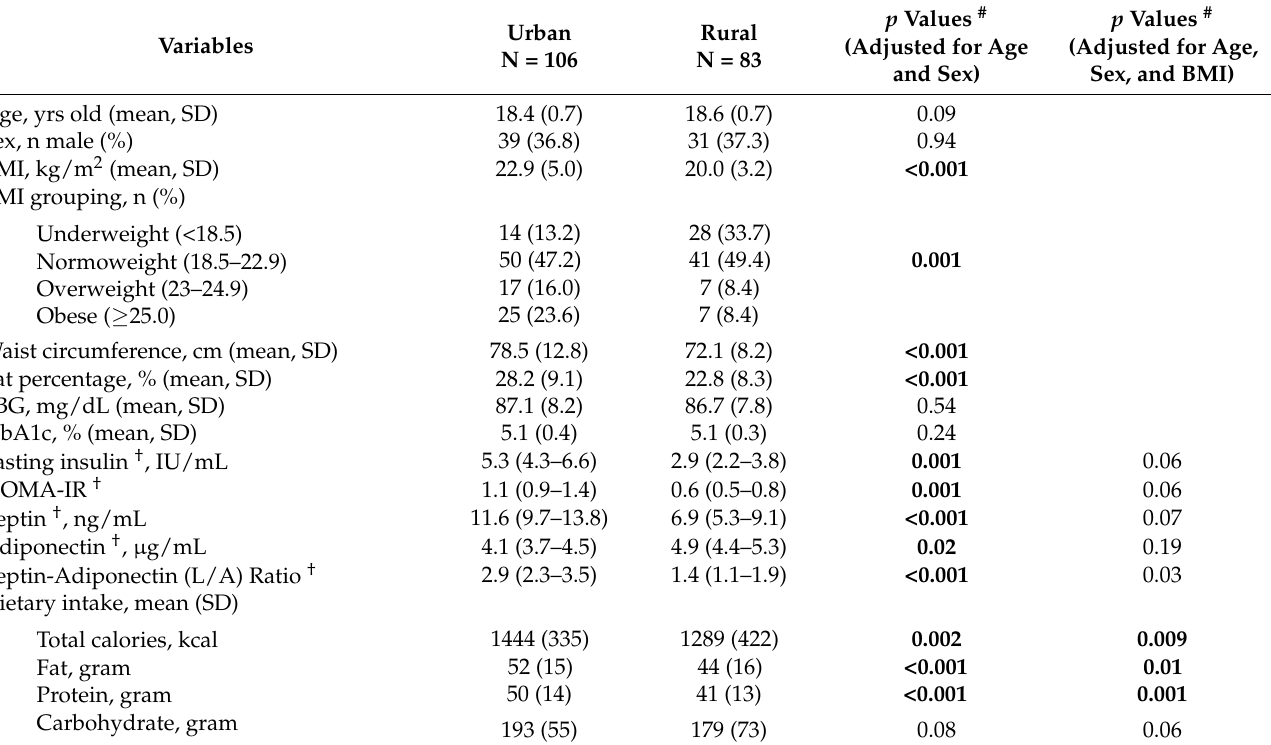
Table 1. Baseline characteristics of the study